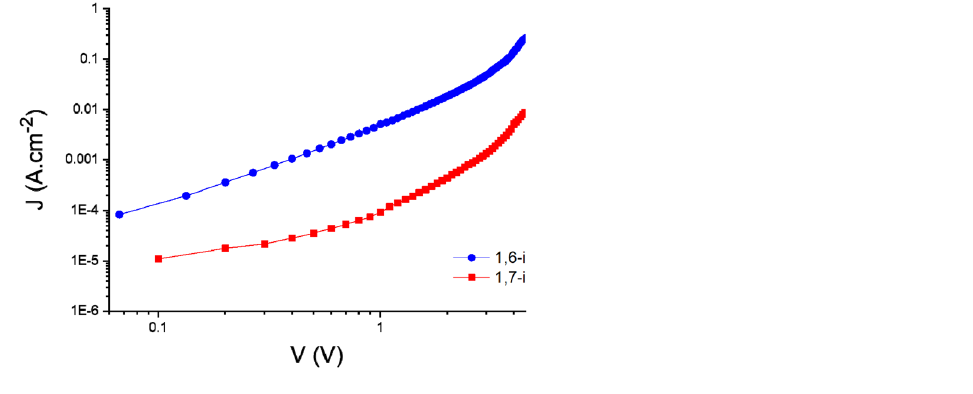
Figure 9. Electron mobility μ e of 1,6-i (blue) and 1,7-i (red) based